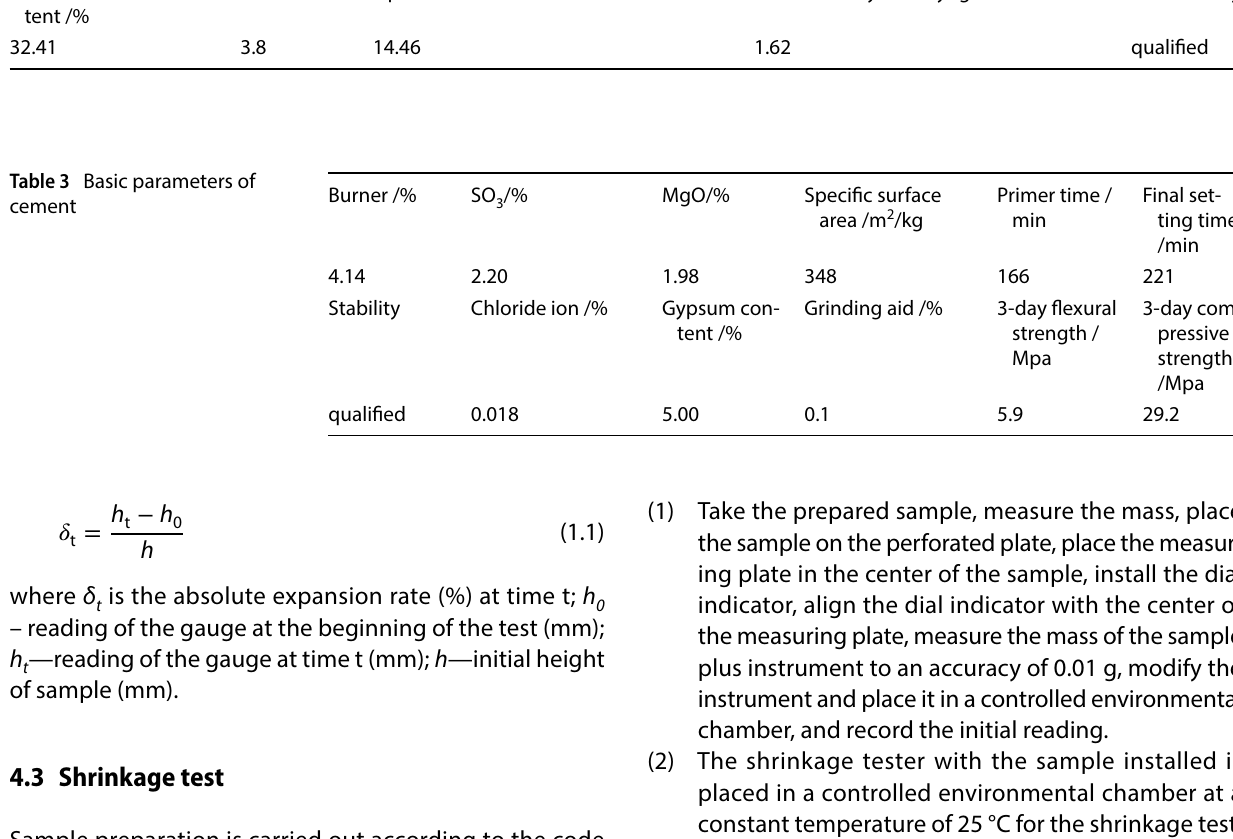
Table 2 Basic physical indexes and chemical analysis results of phosphogypsum Ca/% /% SO 3 Natural moisture con- tent /%